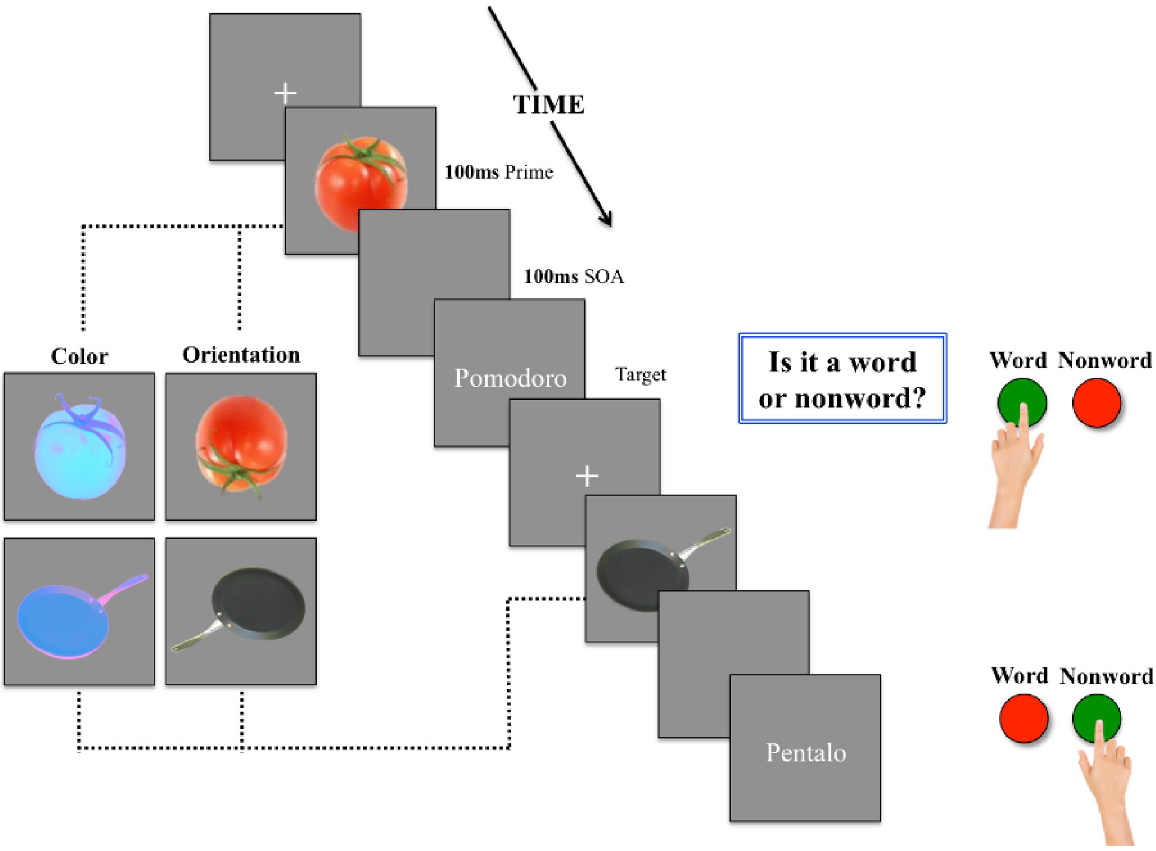
Fig 1. Experimental design schematic of trials of normal condition with color and orientation modification conditions for each category shown to the left. Participants were asked to respond by key press to the question “Is it a word or nonword?” Target strings remained on the screen for 3000ms or until key press.